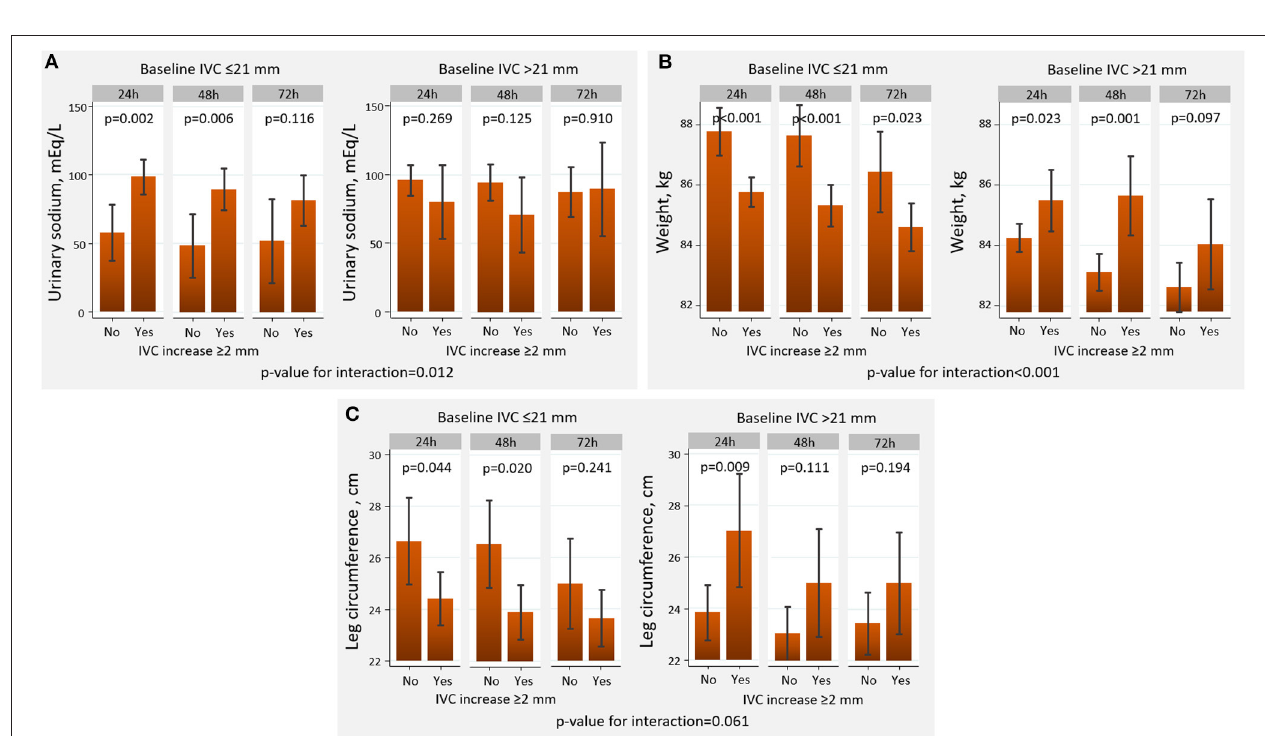
FIGURE 3 | Changes in decongestion parameters across baseline IVC diameter and the presence of IVC increase at 3-h. (A) Urinary sodium. (B) Weight. (C) Leg circumference. IVC, inferior vena cava.